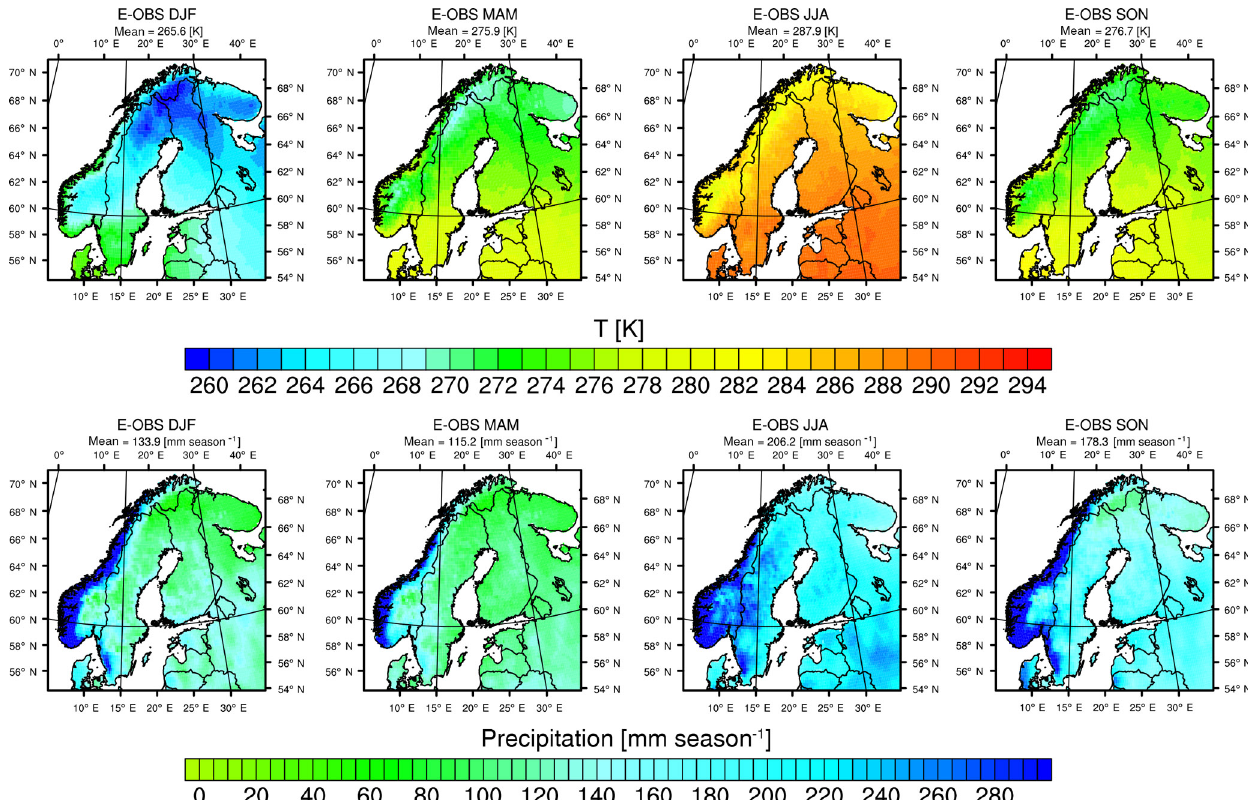
Figure 2. The reference values of 2m temperature and precipitation from E-OBS data. The seasonally averaged results are for the time period of October 1979–March